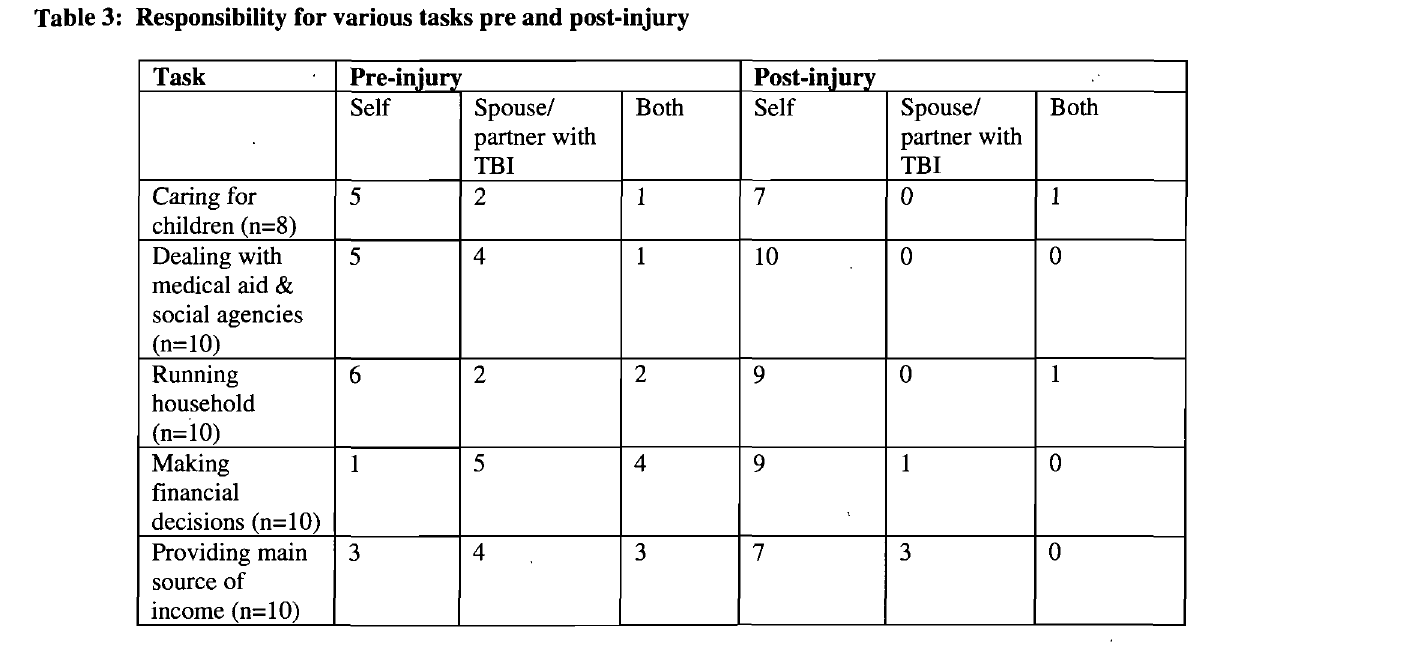
Table 3: Responsibility for various tasks pre and post-injury